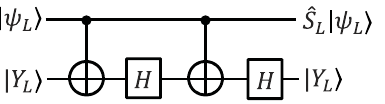
Figure 44: Logic circuit that implements the S (cid:112) | Y 〉 = ( | g 〉 + i | e 〉 ) / 2, on which two controlled logical CNOTs and two logical L L L